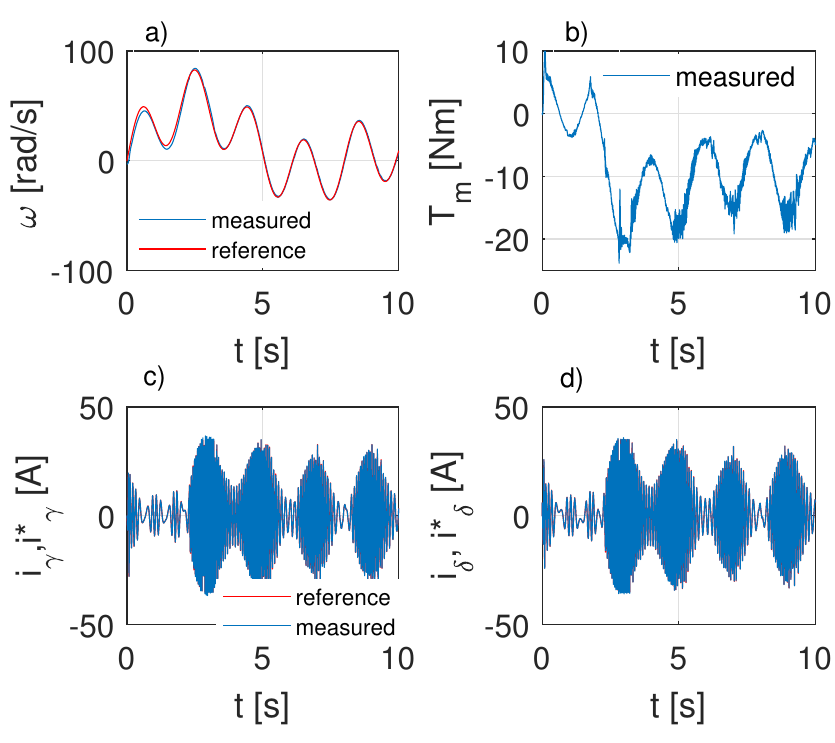
Figure 8. Speed response for harmonic speed reference and a constant load torque starting at t = 1.9 s : reference and measured speed ( a ), measured torque ( b ), reference and measured stator current vector components ( c , d